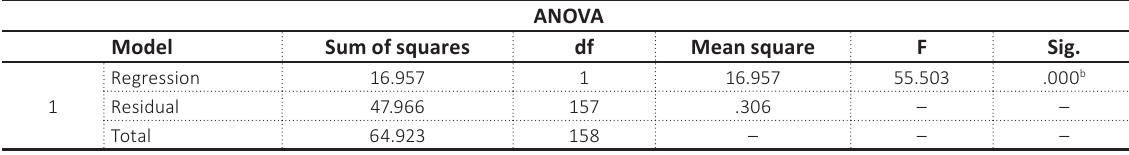
Table 12. Model summary of simple linear regression between leadership and job satisfaction Model Table 13. Analysis of variance between leadership and job satisfaction